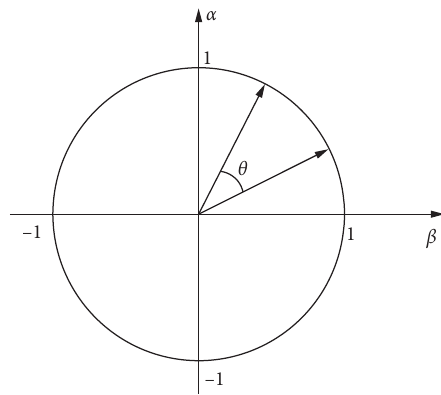
Figure 1: Coordinates of the revolving quantum